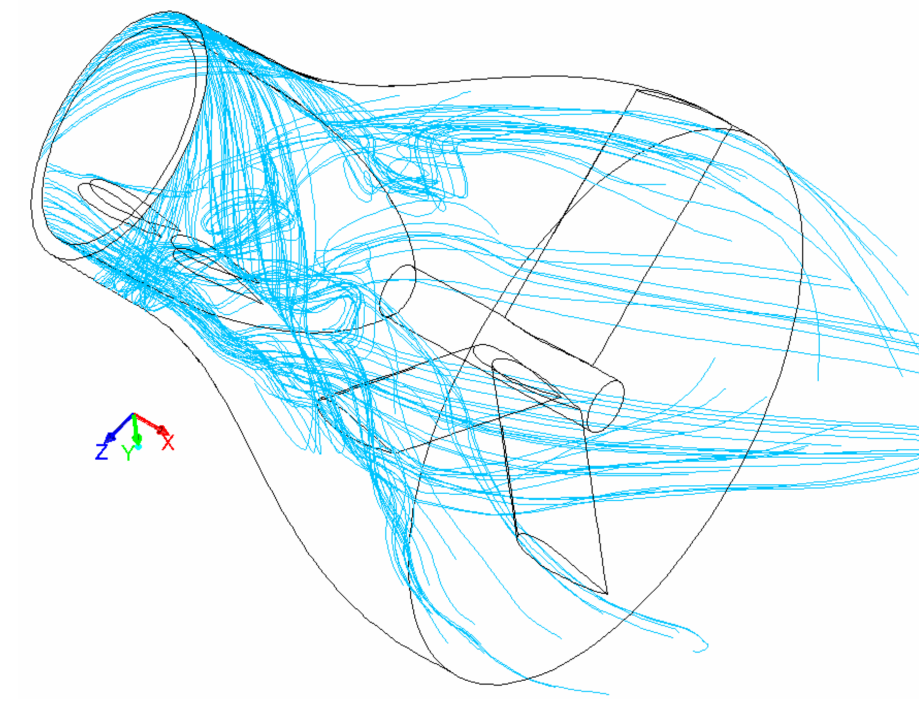
Figure 18. Visualization of the streamlines through the